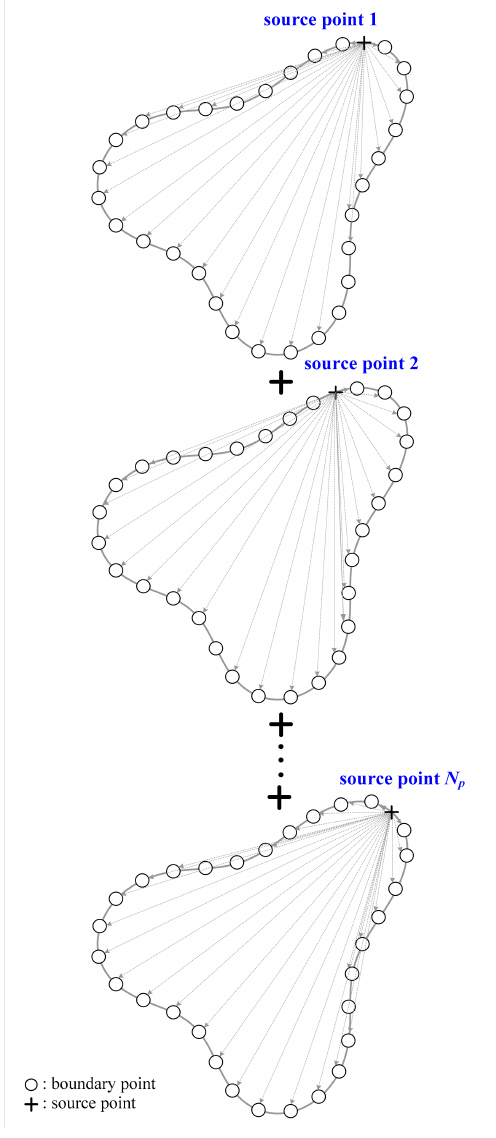
Figure 4. Illustration of the addition theorem for the multiple source meshless